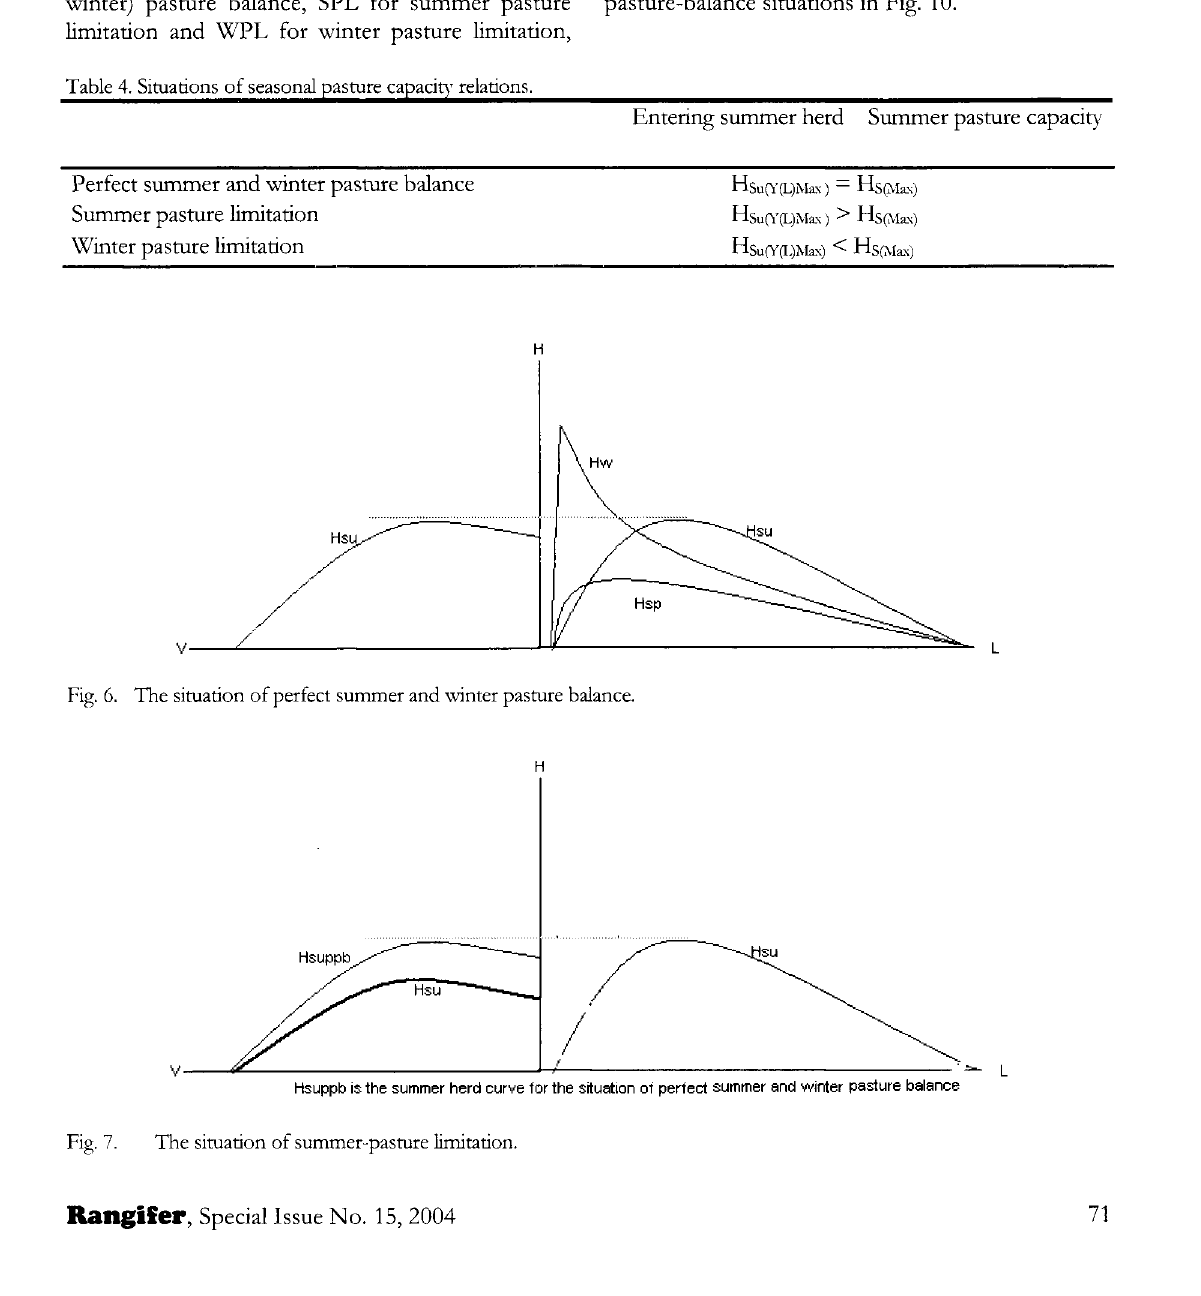
Table 4. Situations of seasonal pasture capacity relations.